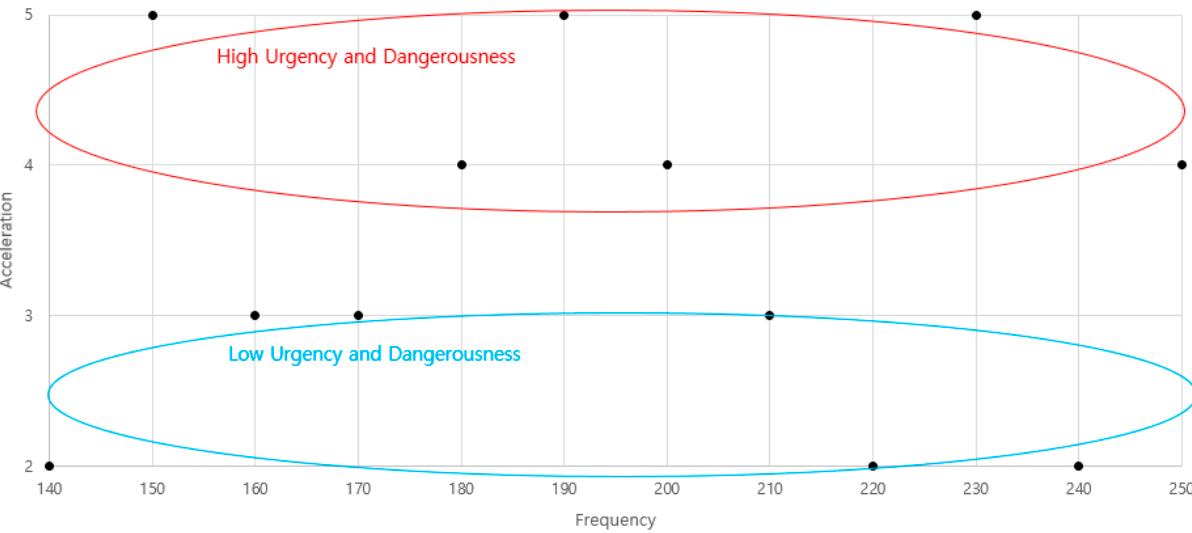
Figure 7. Emotional map of “frequency” and “acceleration”.